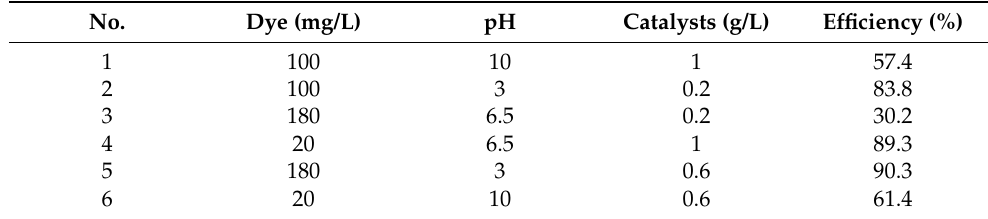
Table 3. Design of experiments with achieved efficiencies (%) in decolourisation process of graphic magenta